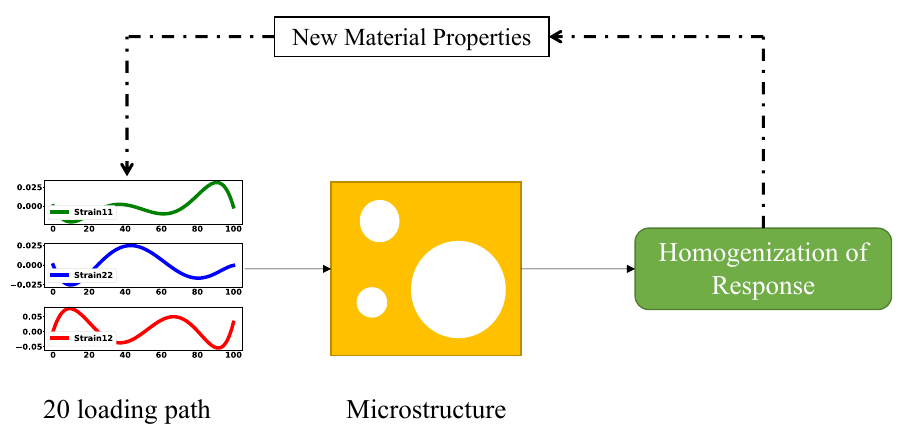
Figure 6. Data generation for linear problem. Twenty loading paths are applied to every microstruc- ture, then the material properties are changed, and the process is repeated.